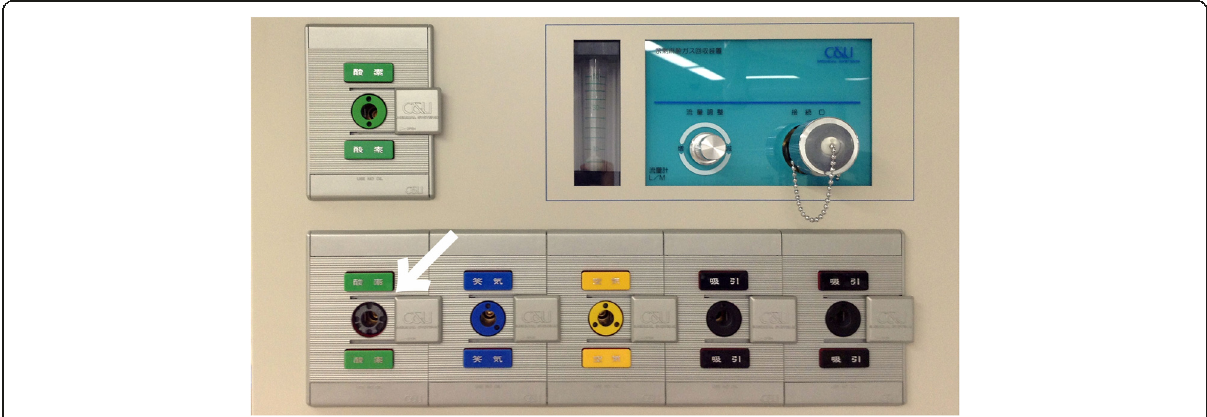
Fig. 2 The ceiling-mounted pendant and the broken socket. The image shows the ceiling-mounted pendant installed in our operating room. The arrow indicates the pendant ’ s broken oxygen